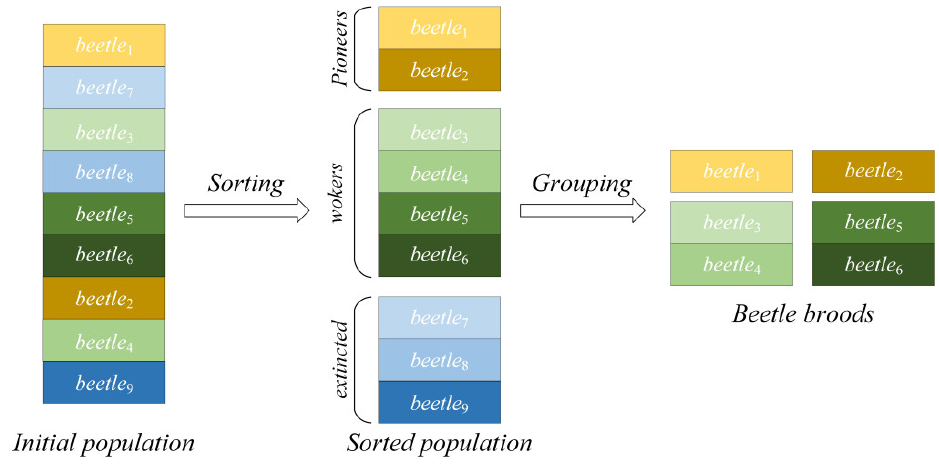
Figure 3. Illustration of the sorting and grouping processes.